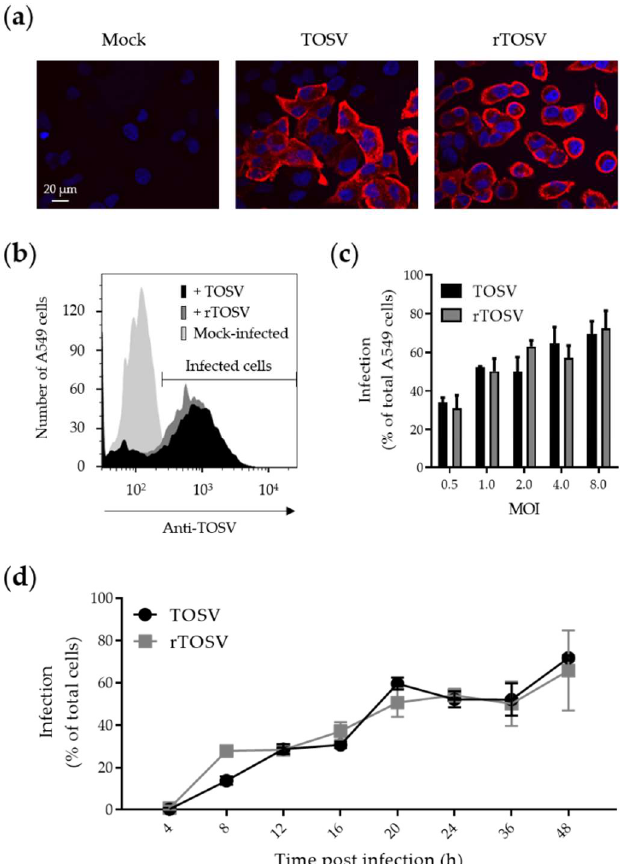
Figure 3. Infection of A549 cells by rTOSV and TOSV. ( a ) A549 cells were infected with TOSV and rTOSV (MOI ∼ 2) for 24 h and then immunostained for the intracellular TOSV structural proteins G N , G C , and N, using an anti-TOSV primary mouse polyclonal antibody and an AF568-coupled anti-mouse secondary monoclonal antibody (red). Nuclei were stained with Hoechst (blue), and samples were imaged by wide-field microscopy; ( b ) Same as in (a), except that infected cells were analyzed by flow cytometry; ( c ) A549 cells were exposed to TOSV and rTOSV at the indicated MOIs for 24 h. Infection was analyzed by flow cytometry after immunostaining against the three structural proteins G N , G C , and N. Error bars indicate SD. Simple linear regression test returned no significant difference between TOSV and rTOSV series of values; ( d ) Infection with TOSV and rTOSV (MOI ∼ 2) was monitored by flow cytometry in A549 cells over 48 h. Error bars indicate SD. Two-Way ANOVA with Geisser-Greenhouse correction and Sidak’s multiple comparison tests returned no significant difference between the TOSV and rTOSV series of values.